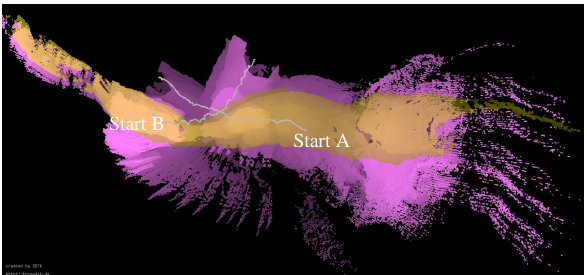
Figure 5. Unwound initial point clouds from dataset T rajectory2D w.r.t. ground truth (semi transparent yellow) from top view. The gray lines depict the estimated trajectory from HectorSLAM. At the beginning of each run A and B the point clouds match the reference cloud, but quickly diverge.